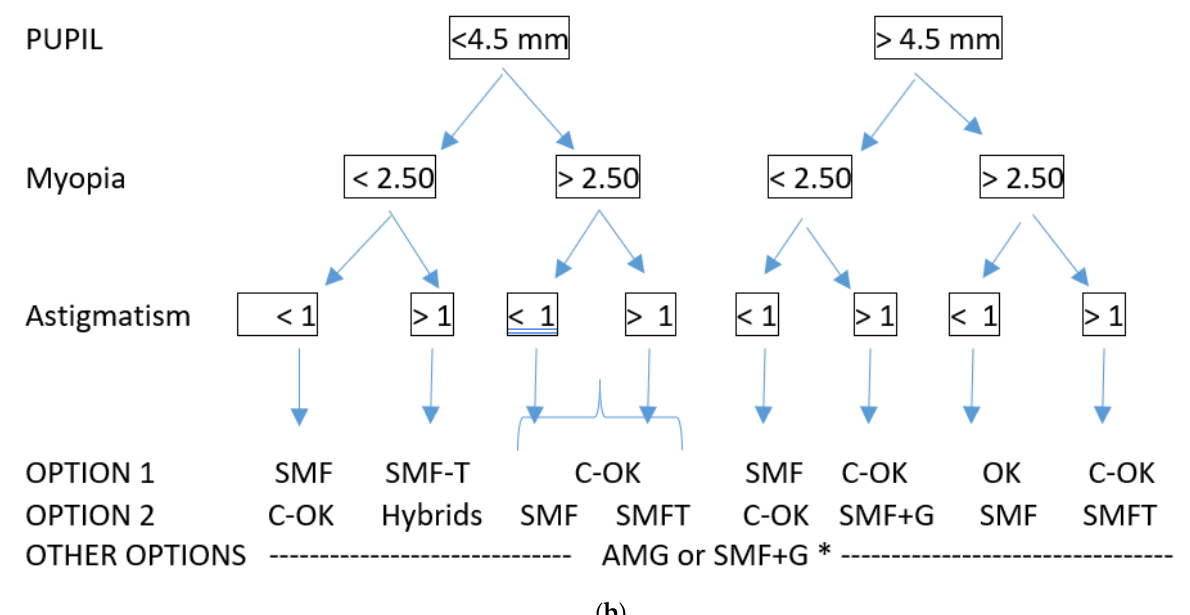
Figure 1. ( a ) Myopia control strategy Decision tree. ( b ) Contact lens selection decision tree. SMF: Soft multifocal, distance- centered, high add. SMF-T: Soft multifocal toric, distance-centered, high add. C-OK: Custom OrthoK (or OK with smaller central zone). OK: OK regular design (4–5 curves/standard central zone). G: Regular glasses (single vision). AMG: Anti-myopia glasses (lenses designed to control myopia). Hybrids: Duette progressive, distance-centered: customizable zone + add power (>+3D). * In some countries, customized soft MF lenses may be also an option (zones + add power customizable).